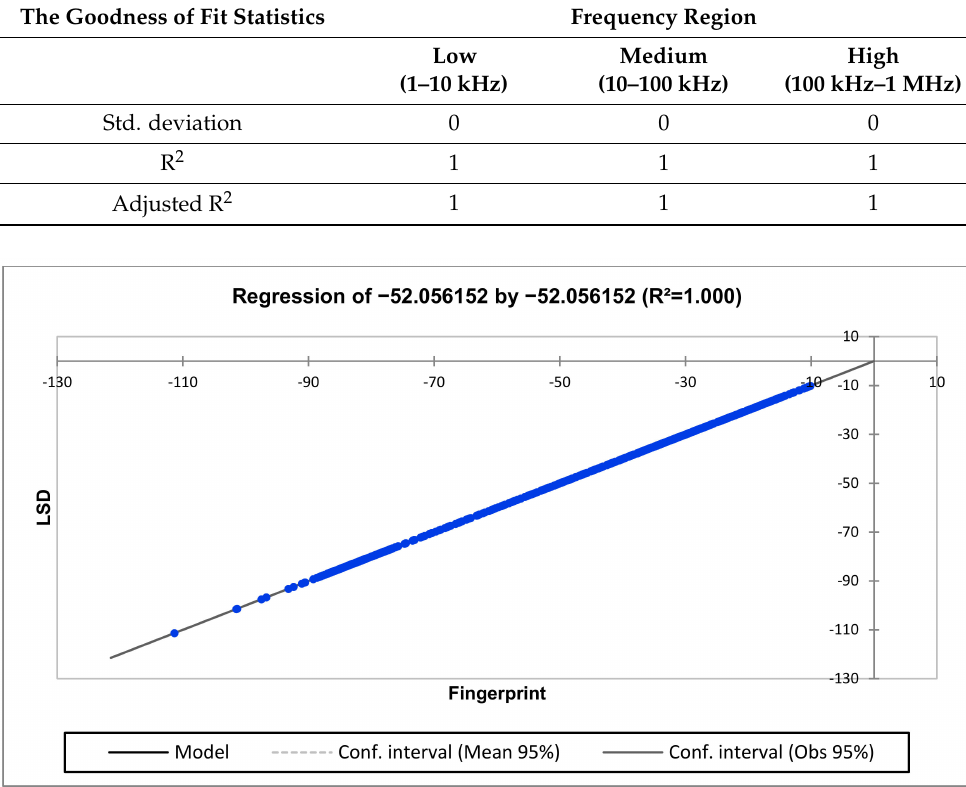
Figure 8. Regression for healthy winding